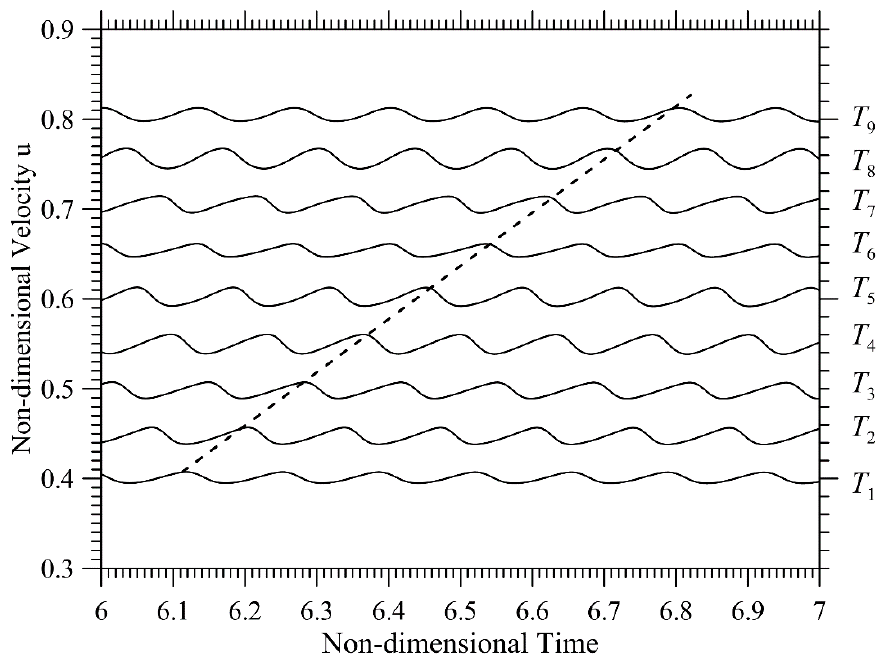
Figure 3. Velocity component u probed at fixed positions evenly spaced along the x direction, as a function of time.